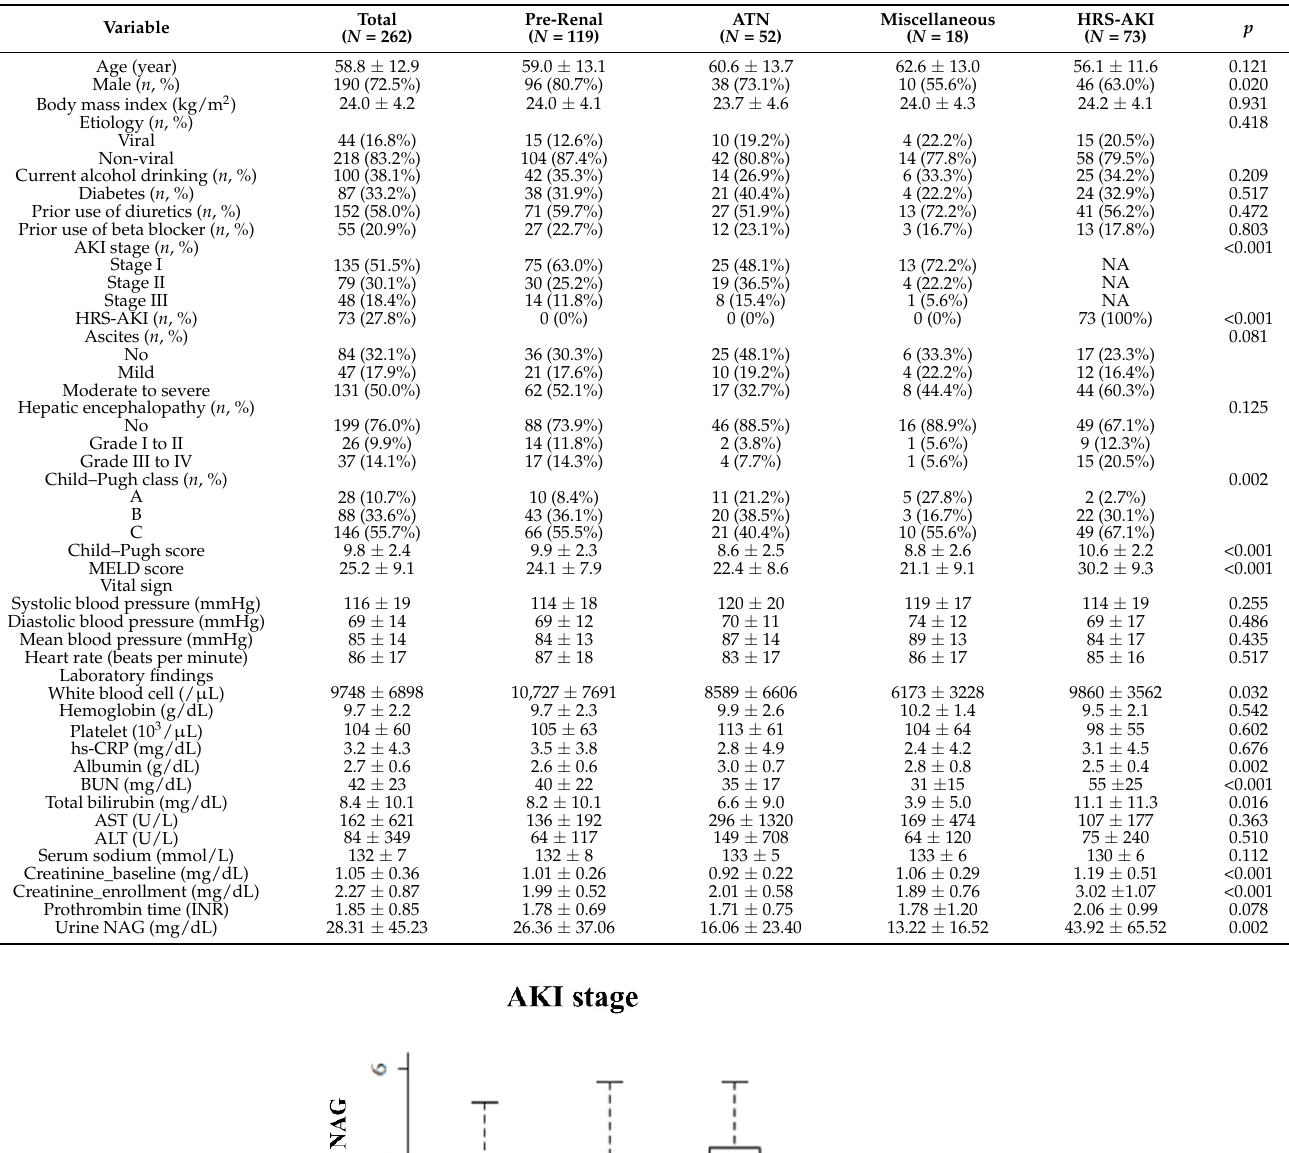
Table 1. Baseline characteristics and AKI phenotype.